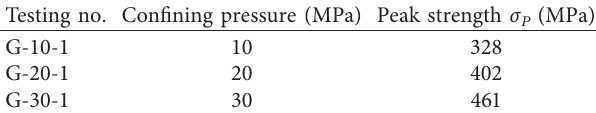
Table 2: Testing results of triaxial compression